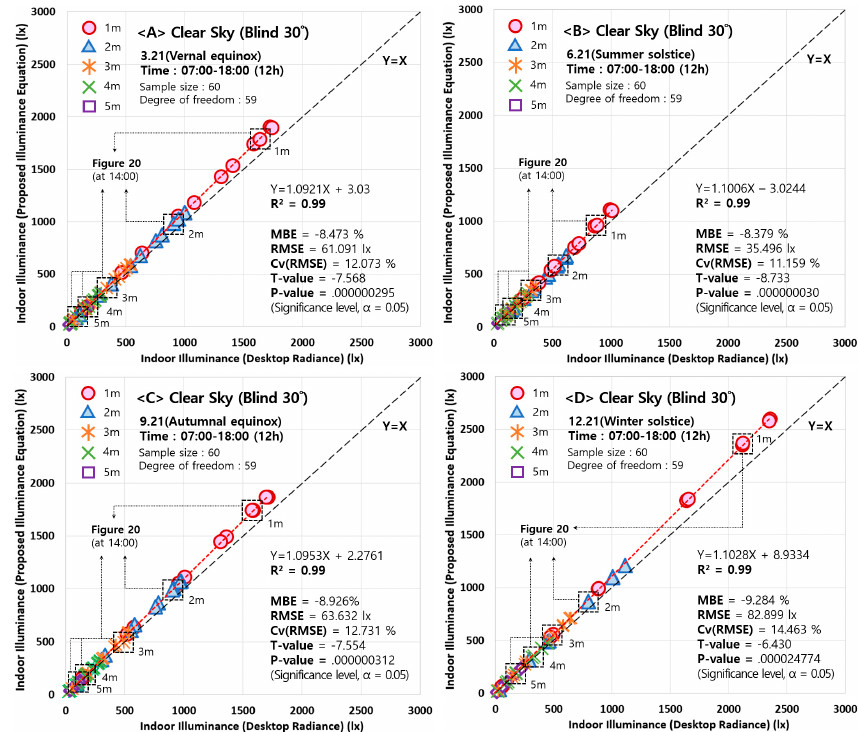
Energies 2019 , 12 , x 29 of 36 Tables S5–1, S5–2, S5–3, and S5–4 in the supplementary material provide detailed data for 21 st Figure 21. Comparison of indoor illuminance between the modified equation and Desktop Radiance in CIE clear sky when installing blind 30° ( A ) 3.21 ( B ) 6.21 ( C ) 9.21 ( D ) 12.21 (07:00–18:00).